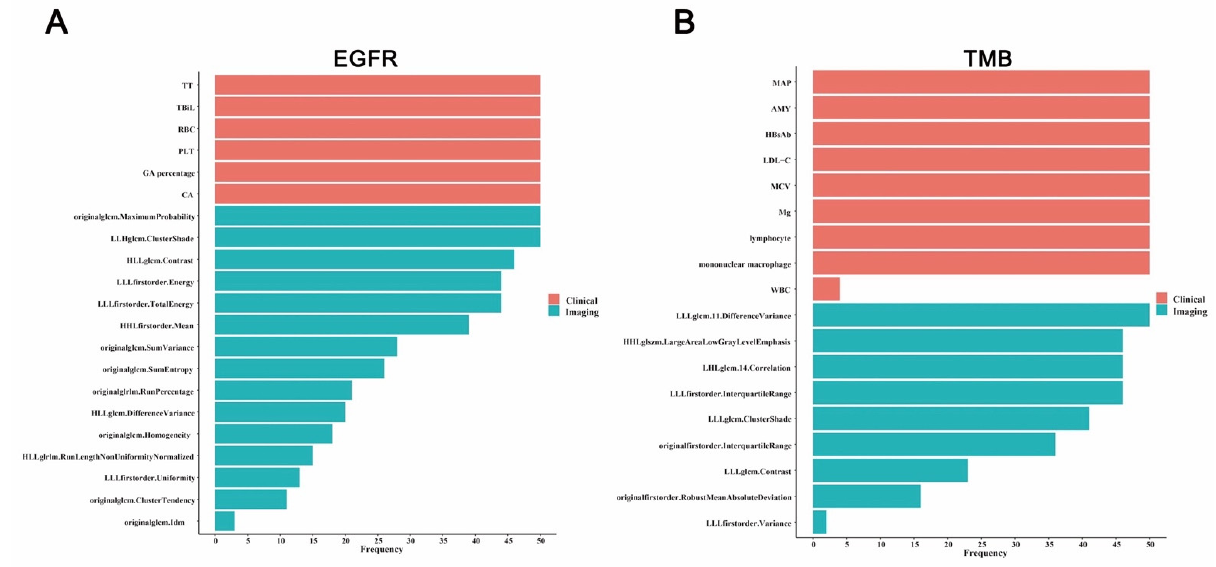
Figure 2. The importance of selected variables for EGFR mutations ( A ) and TMB status ( B ) prediction model. The importance means the variable frequency counted among 50 times lasso regres- sions.